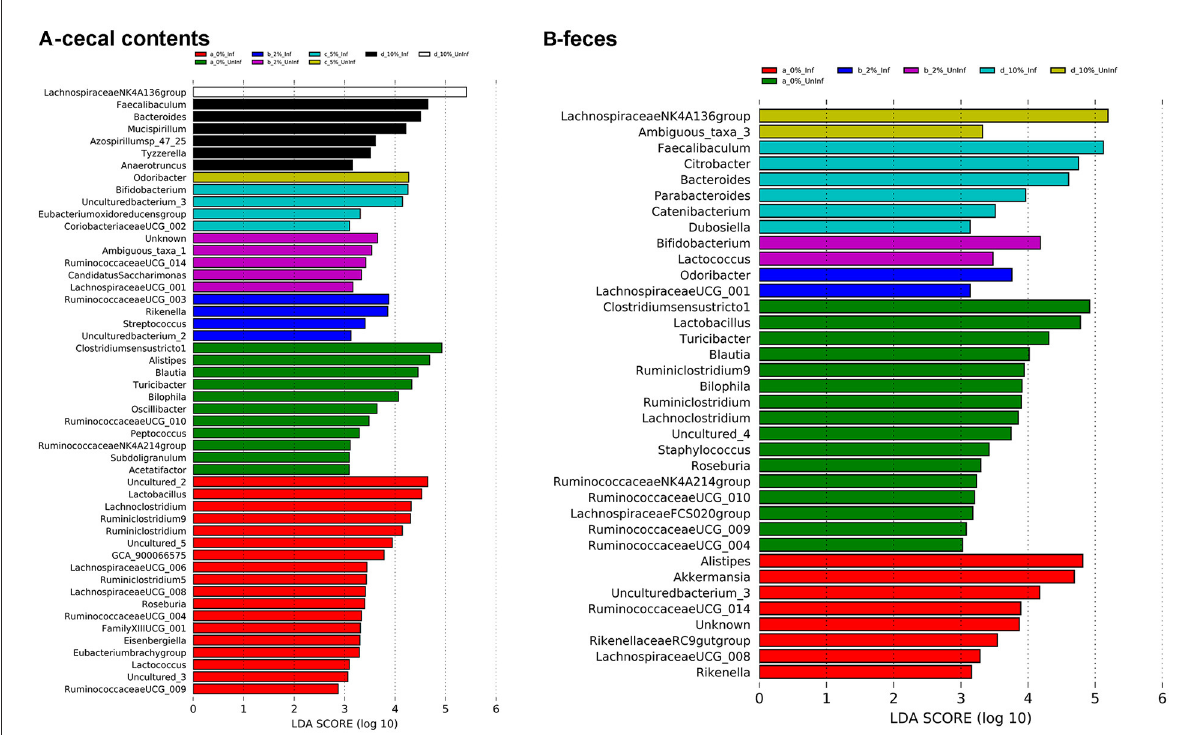
FIGURE6 LEfSe plots identify discriminating genera in uninfected and infected mice. LEfSe plots were generated from16S sequences data from uninfected and infected mice fed different levels of dietary RPS and identified various genera that were discriminant for the various treatments. (A)